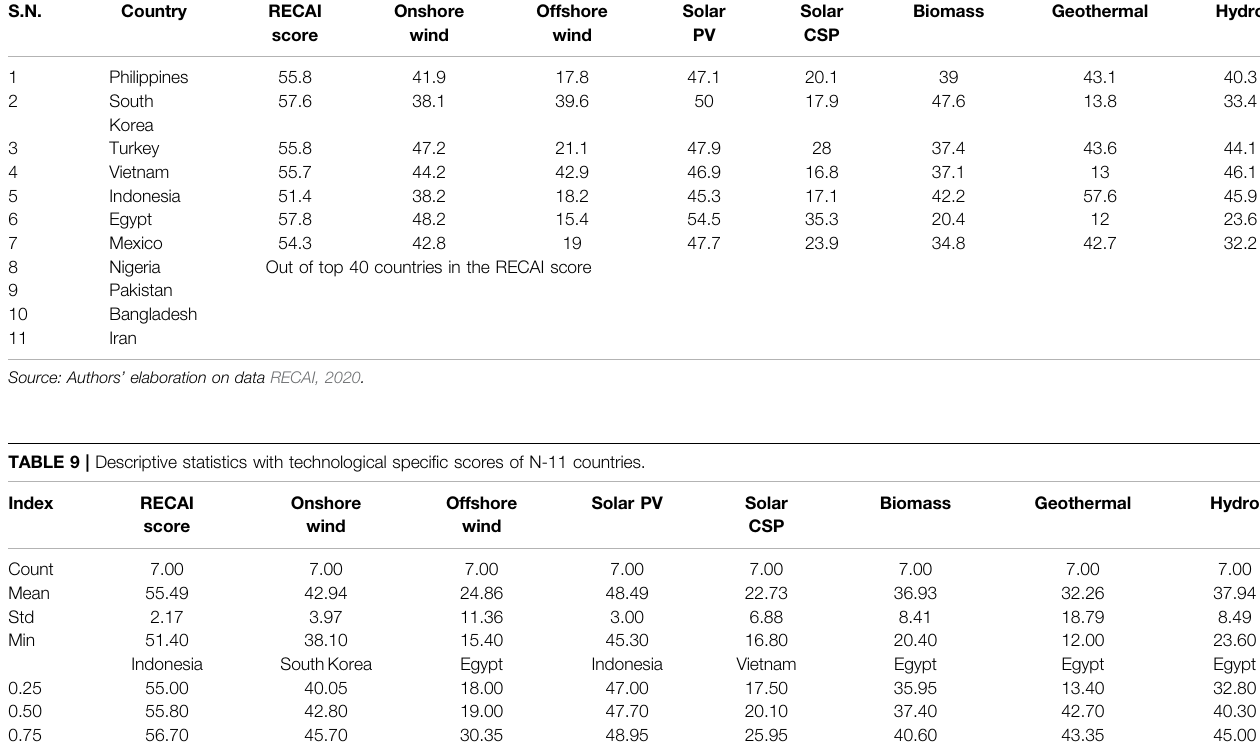
TABLE 8 | Next-11 countries that invest in renewable sources. General information